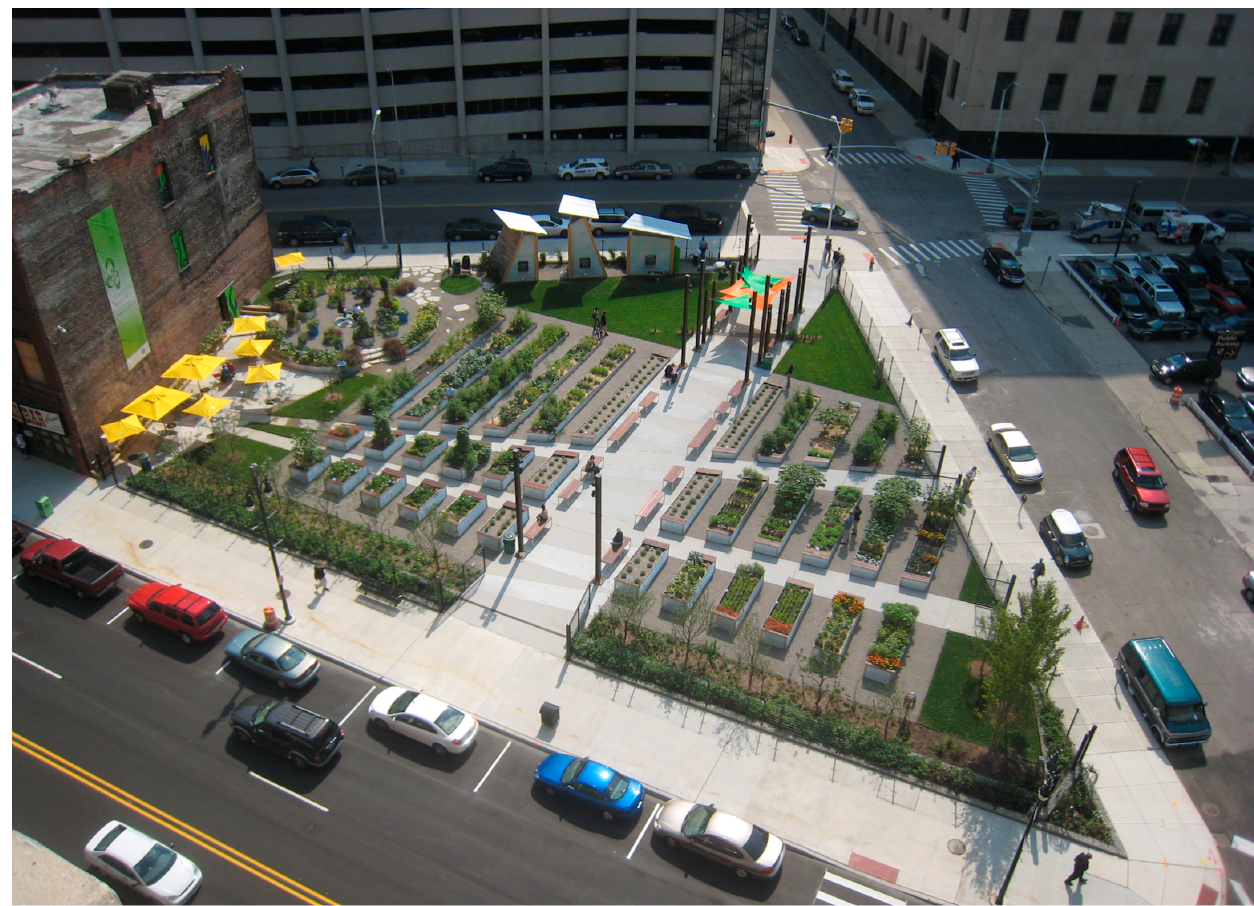
Figure 8. Aerial view of Lafayette Greens in downtown Detroit. Image from authors.